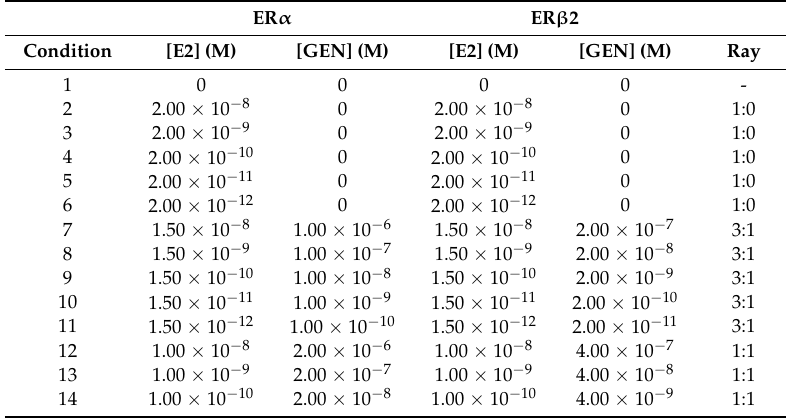
Table 2. Experimental ray design for the assessment of the effects of estradiol (E2) and genistein (GEN) alone and in mixtures on the luciferase activity in U251-MG cells transfected with zebrafish